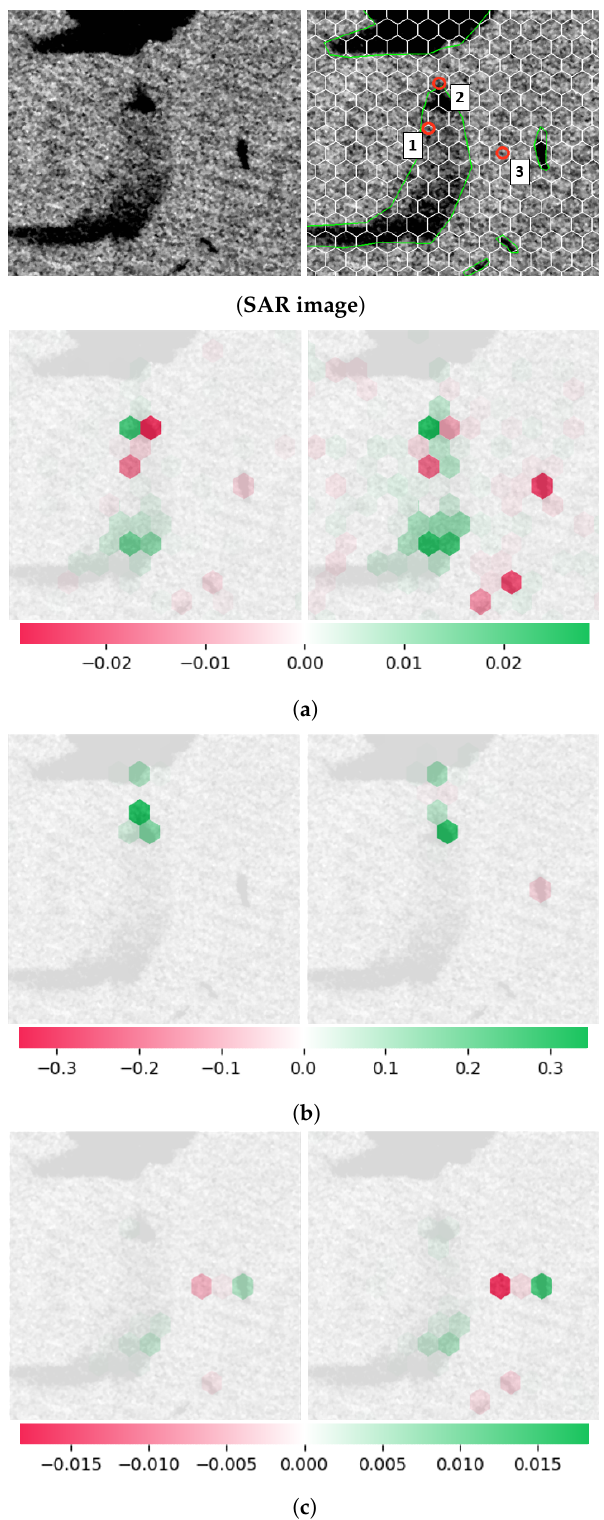
Figure 22. Results of SHAP explanation function. ( a ) SHAP images for pixel number 1, classified as sea; ( b ) SHAP images for pixel number 2, classified as slick; ( c ) SHAP images for pixel number 3, classified as sea. ( SAR image ) right : SAR image, left : SAR image with a grid of white super-pixels representing the SHAP input. The ground truth is outlined in green and the pixels considered are numbered and circled in red. For SHAP image rows, right corresponds to the information obtained through the network T SAR , and left corresponds to information obtained through the T 1